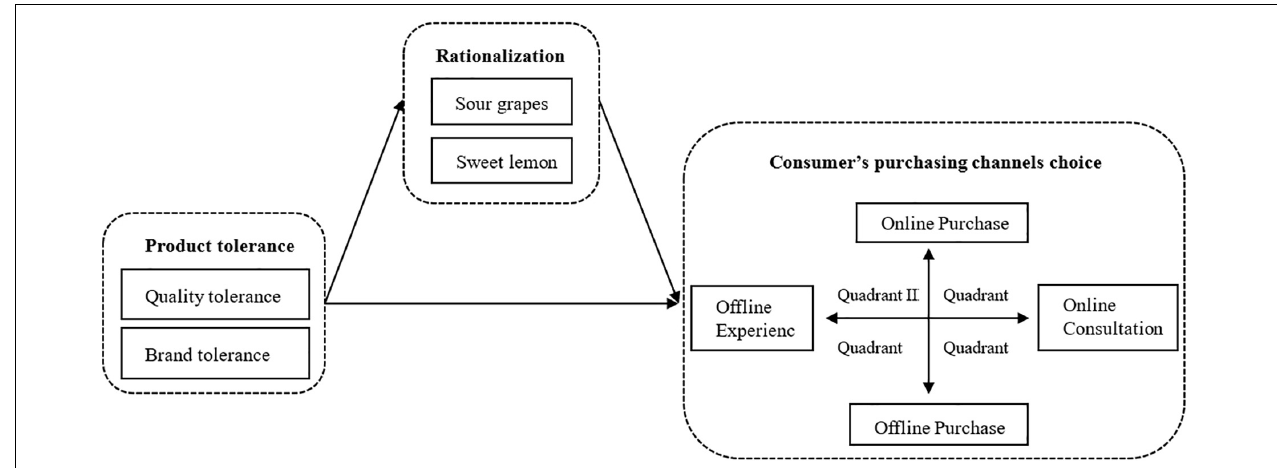
FIGURE 1 | The relationship model between product tolerance, rationalization, and consumer’s shopping channels